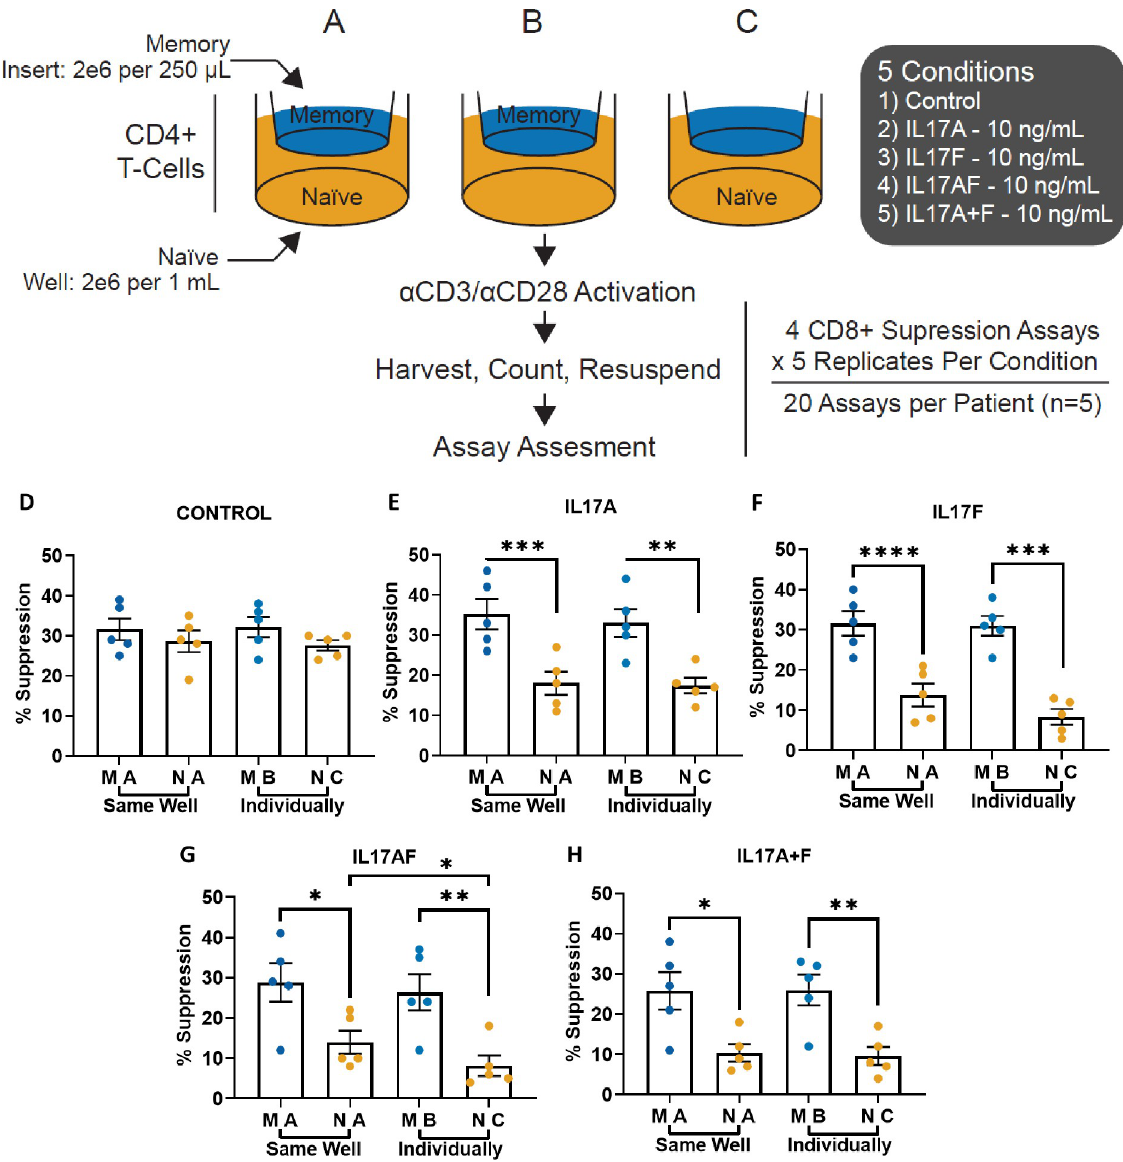
Fig 3. Memory T-cell non-responsiveness to IL-17 is not affected by local auto/paracrine action of na ï ve T-cell cytokines. Transwell cultures were set up in 24-well plates with transwell membrane inserts separating autologous presorted Memory and Na ï ve CD4 + T cells together (A) or individually (B and C), with indicated cytokine conditions (media alone, IL-17A, IL-17F, IL-17AF and IL-17A+IL-17F, panels D-H, respectively) stimulated with anti-CD3/anti-CD28-coated beads in culture for 7 days. On day 7, the cells were harvested, washed, stained with CFSE and subjected to CD8-mediated T-cell suppression assays with fixed anti-CD3 and anti-CD28 stimulation. Mean suppression +/- SEM for the 5 conditions is shown; n = 5 each; * p < 0.05, ** p < 0.01, *** p < 0.001, **** p < 0.0001.